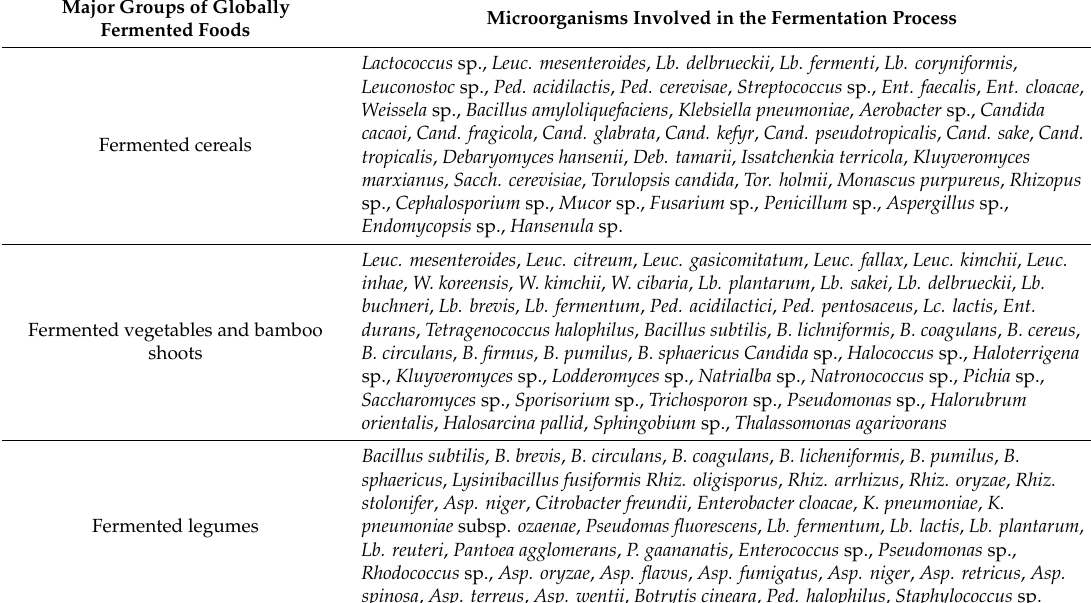
Table 1. A list of microorganisms involved in the fermentative processes of the main categories of globally fermented foods with examples of microorganisms involved in the corresponding fermentative processes. Information reported in accordance to Tamang et al. [3], with integrations from other studies